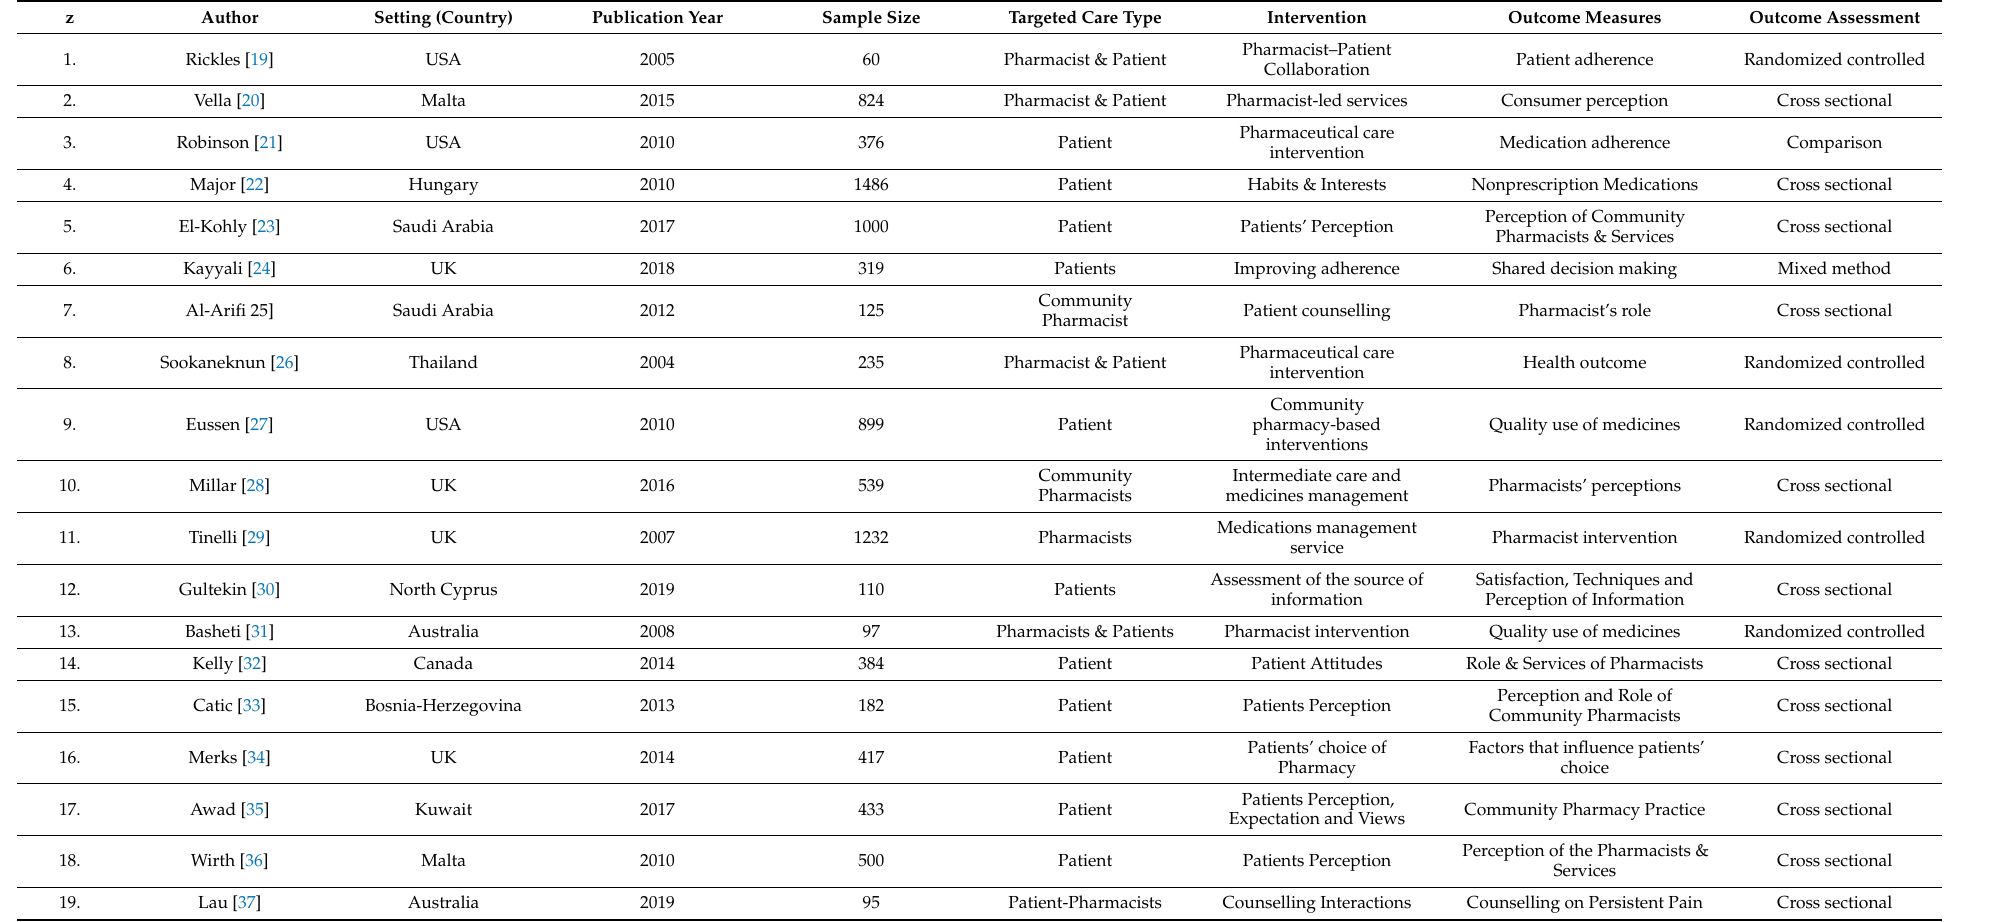
Table 2. Characteristics of the included